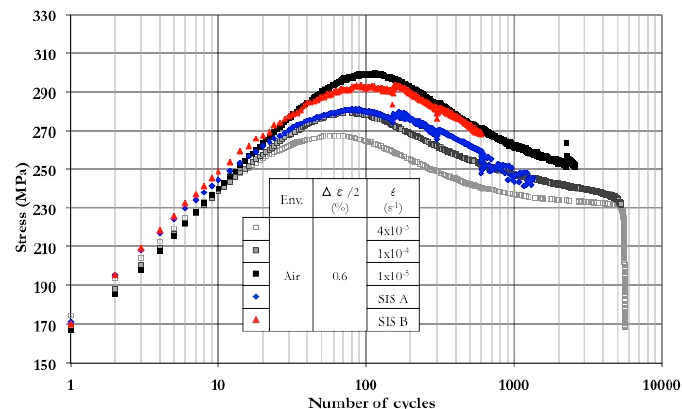
Figure 4. Peak stress as a function of the number of cycles in air with triangular signals at different strain rates and with SIS A and SIS B signals.